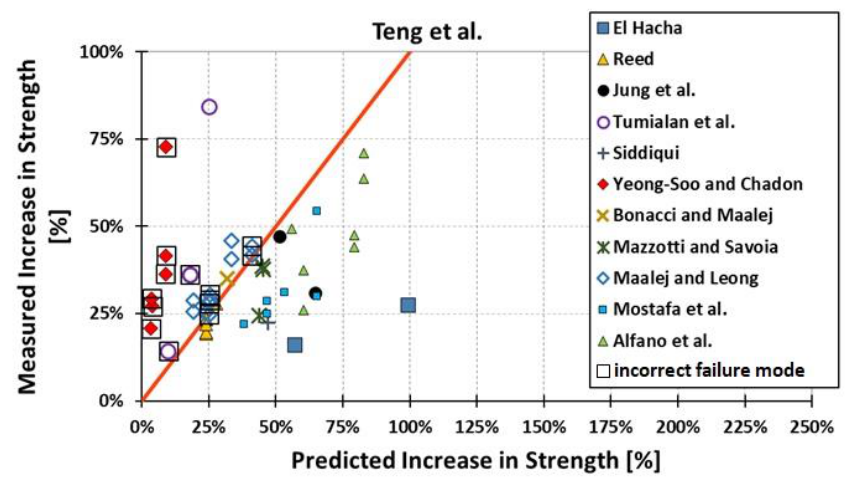
Figure 12. Measured increase in flexural strength versus fib bulletin 14 prediction.